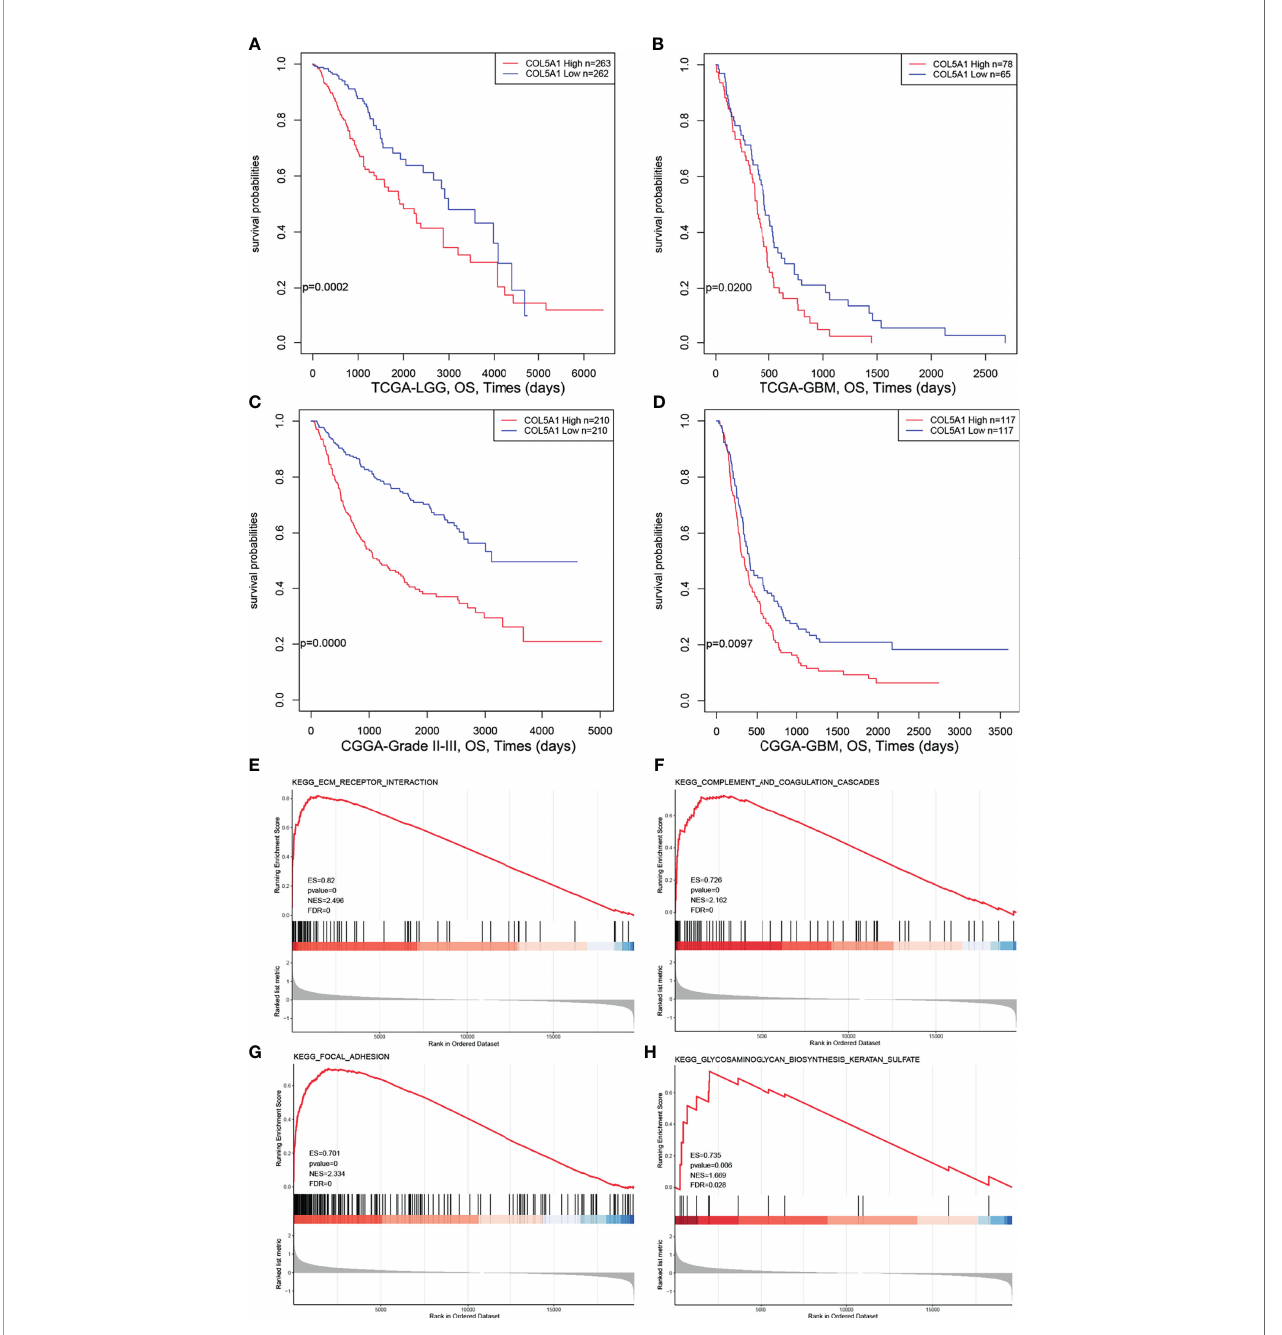
FIGURE 2 | High expression levels of COL5A1 indicates poor prognosis and correlates with KEGG pathways related to tumor progression. (A – D) Survival analysis based on expression levels of COL5A1. (E – H) The top four positive KEGG pathways of GSEA based on COL5A1 (ES, enrichment score; NES, normalized enrichment score; FDR, false discovery